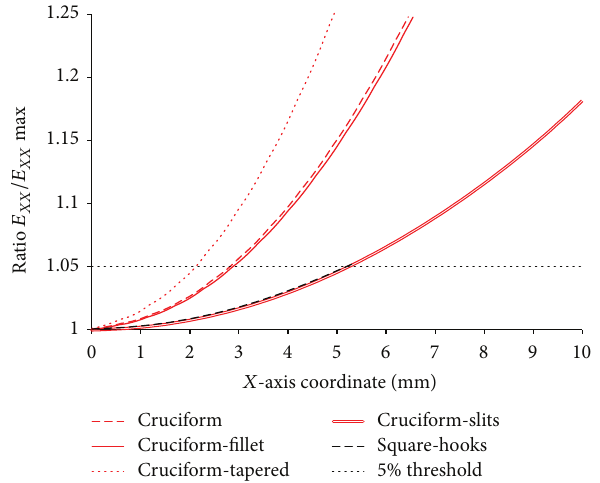
Figure 11: Variation of biaxiality index 𝑅 biax along symmetry axis.